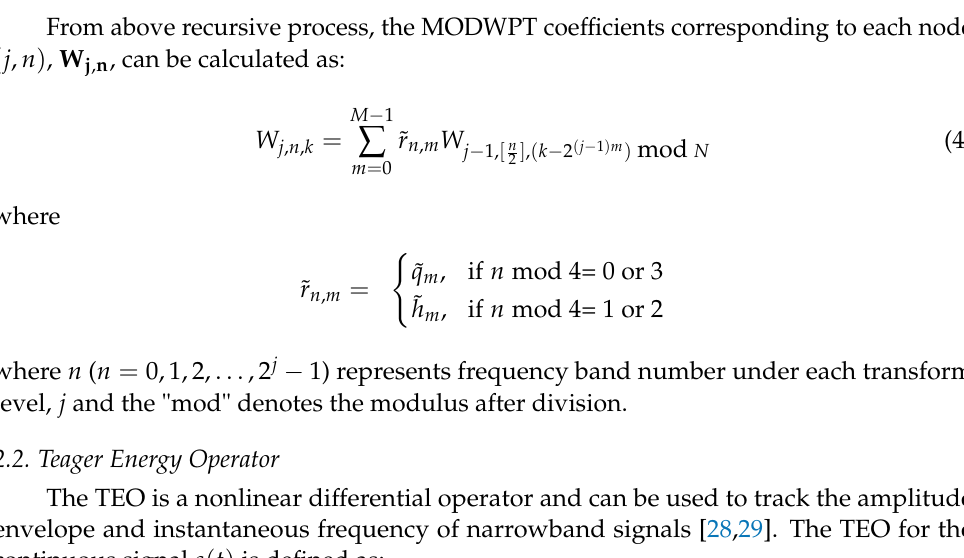
Figure 1. Four levels of the MODWPT decomposition of a time series X